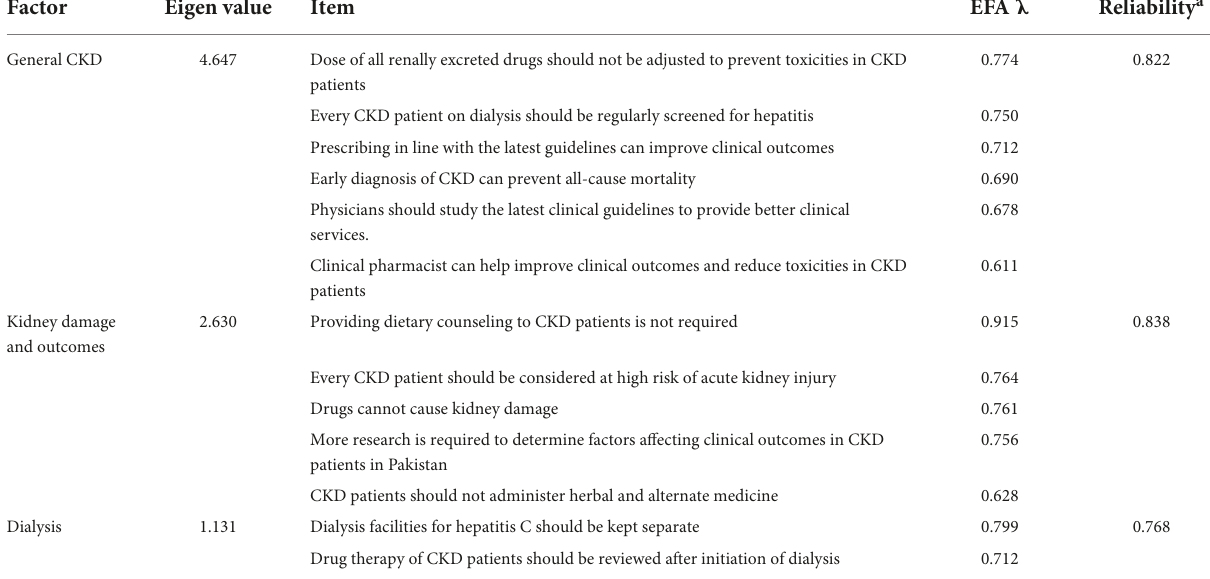
TABLE 4 Results of the EFA analysis in the attitude section of the validation